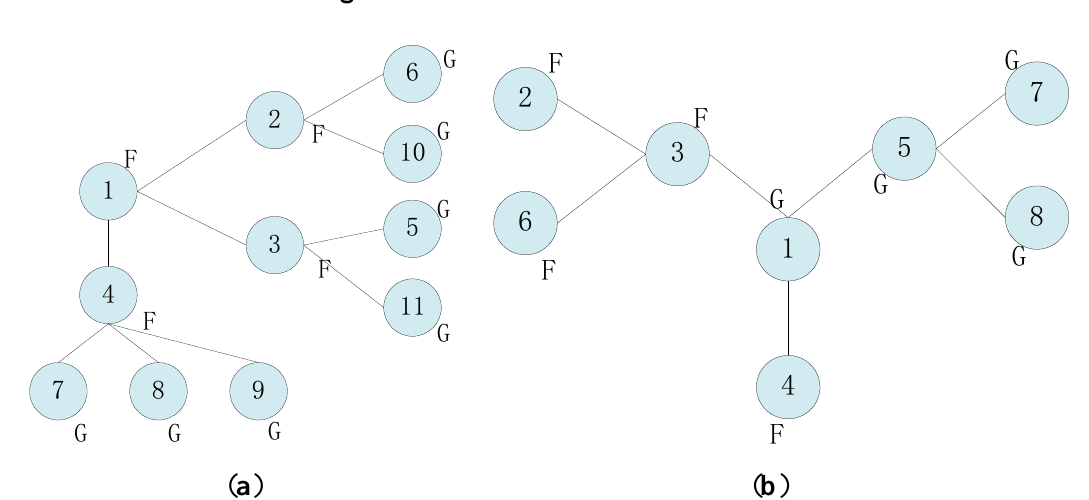
Figure 1. Fault detection